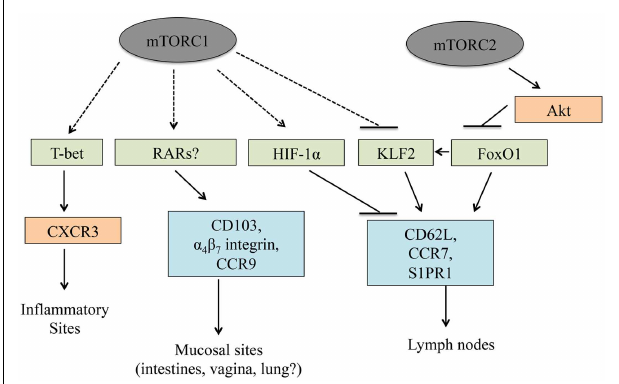
FIGURE 4 |T cell trafficking is linked to mTOR . mTORC1 and mTORC2 controlT cell trafficking by regulating the expression and/or functional activation of multiple transcription factors. In this manner, mTOR signaling regulates trafficking into inflammatory sites, lymph nodes, and mucosal